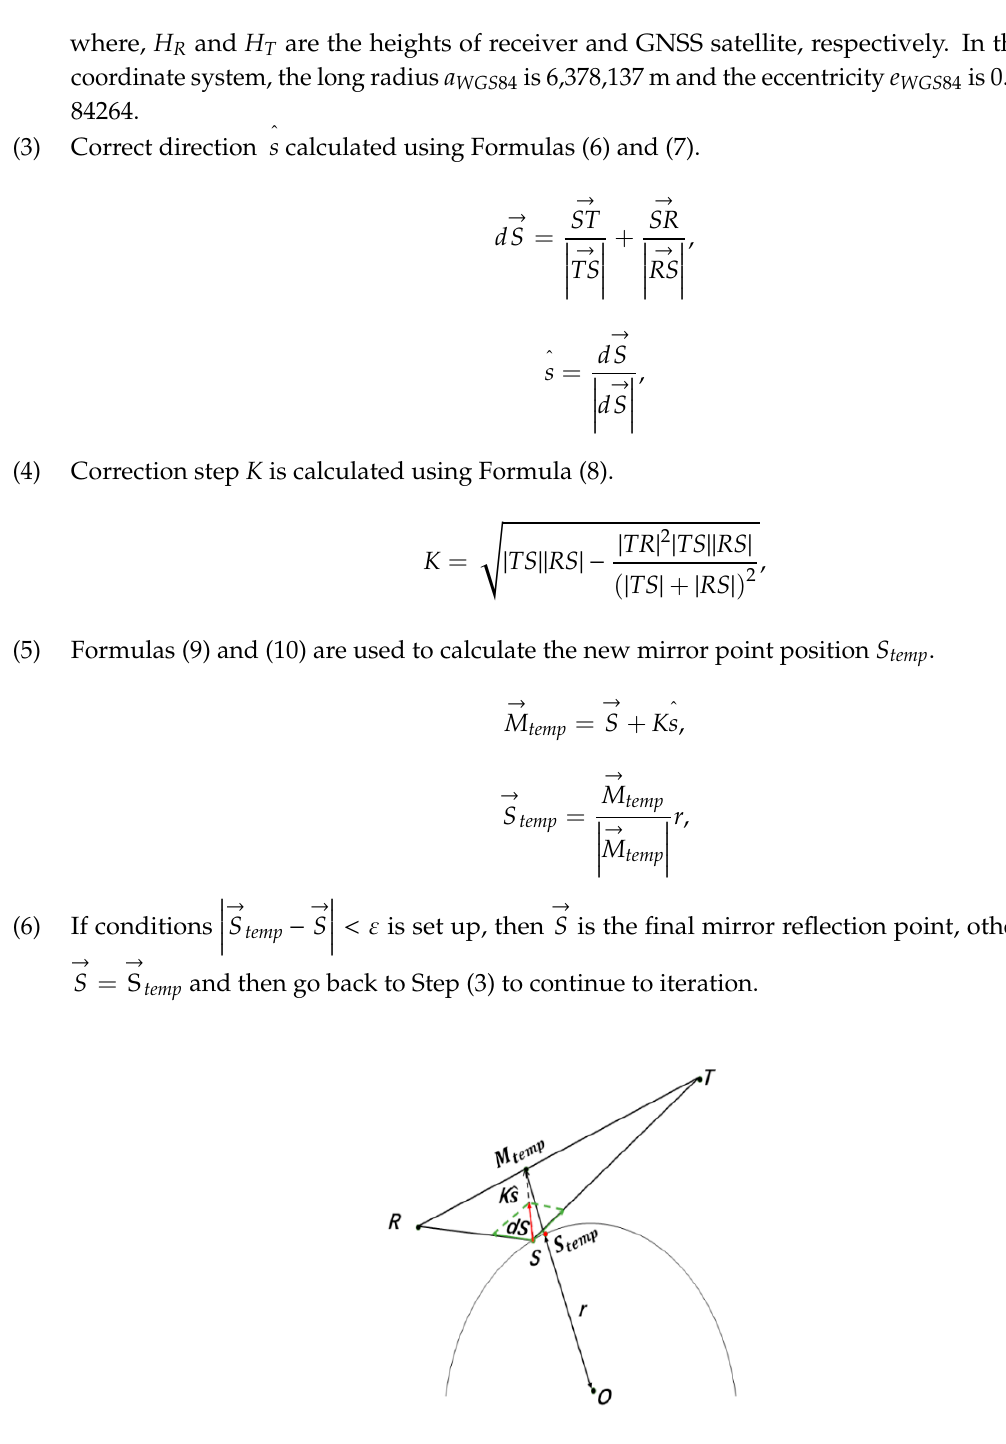
Figure 3. Specular reflection point search based on angular bisector.